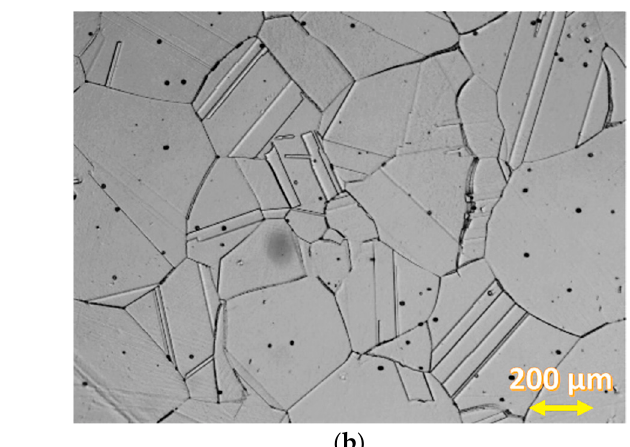
Figure 7. ( a – c ) S355J2W+N steel, ferritic–pearlitic microstructure under di ff erent magni fi cation. The microstructure observations were performed on the LM (light microscopy) observation under various magni fi cations. The specimen was digested in Adler’s A11 reagent. Figure 8 shows the ferritic–pearlitic microstructure of the base material.